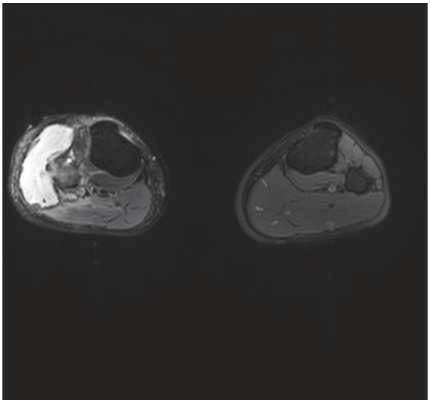
Figure 2: Sagittal MRI section of the lower limbs. We notice the presence of a T2 hypersignal at the level of the proximal right fibular head, with erosion of the lateral cortical bone and extension into adjacent soft tissues in the form of a